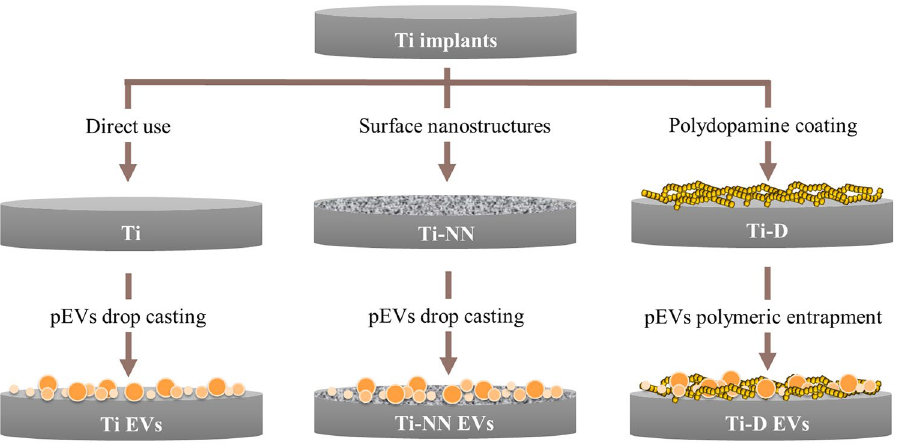
Figure 1. Implant functionalization strategies. Titanium discs were prepared for their direct use (Ti), nanostructuration (NN) or dopamine deposition (D). Coating was done by adding a pEVs solution to obtain Ti functionalized with EVs (Ti-EVs), NN functionalized with EVs (NN-EVs) or D functionalized with EVs